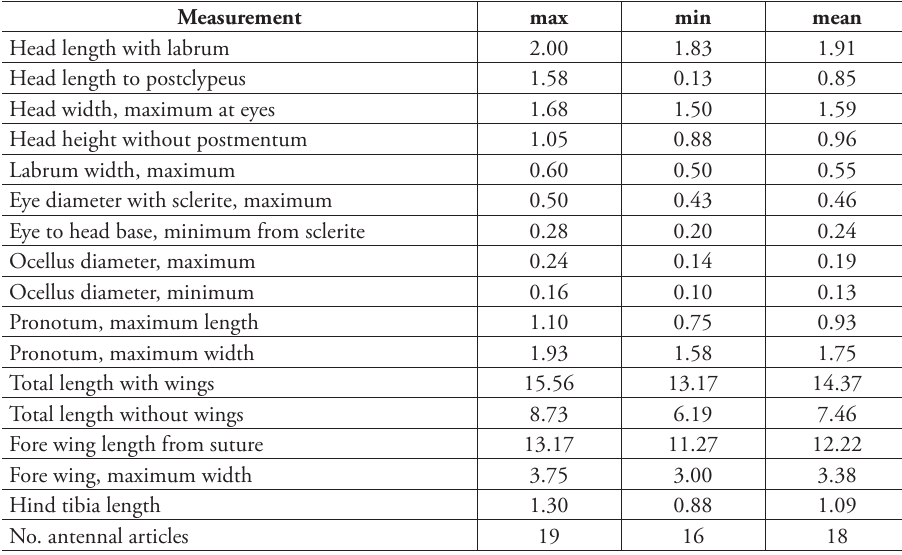
Table 1. Measurements of Neotermes aburiensis imago